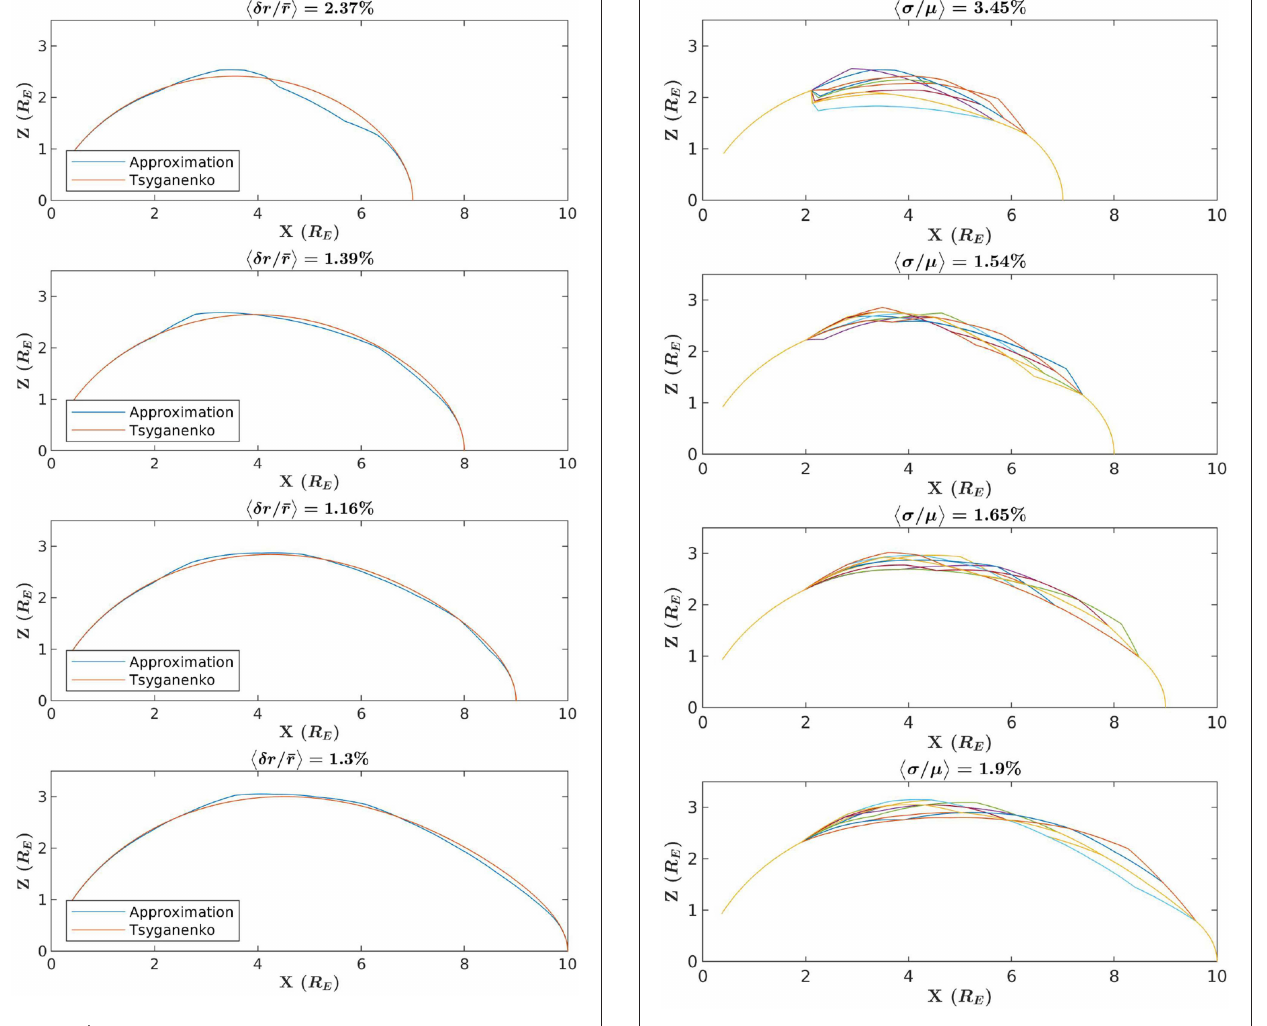
FIGURE 10 | The 10 curves generated by via the brute force implementation of the method that have the least < f ′′ > in comparison to each other. Each panel is an example comparison where a different launch point was selected. Above each example is a percent error, here computed from the mean variance of f divided by the mean averaged over θ